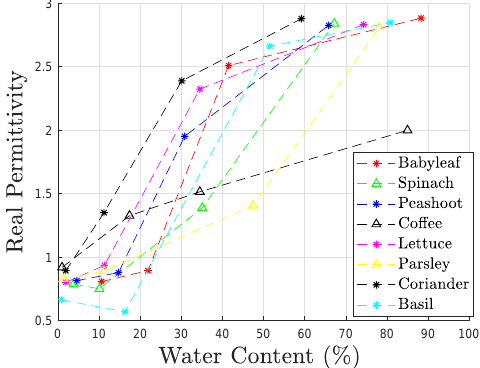
Figure 5. Correlation of permittivity with loss of WC in leaves.